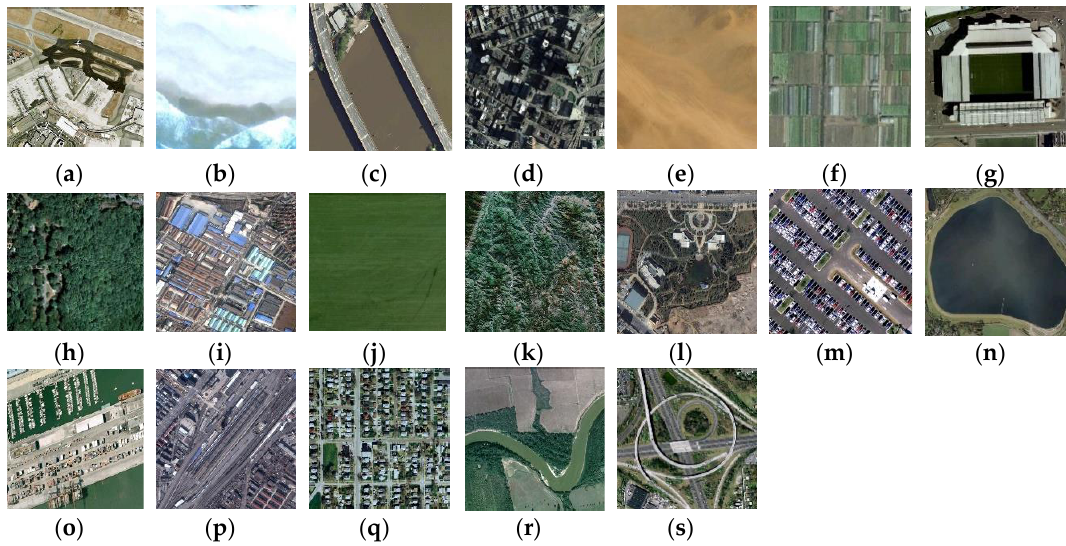
Figure 7. Image classes in WHU-RS dataset: ( a ) airport; ( b ) beach; ( c ) bridge; ( d ) commercial; ( e ) desert; ( f ) farmland; ( g ) football field; ( h ) forest; ( i ) industrial; ( j ) meadow; ( k ) mountain; ( l ) park; ( m ) parking; ( n ) pond; ( o ) port; ( p ) railway station; ( q ) residential; ( r ) river; and ( s ) viaduct.